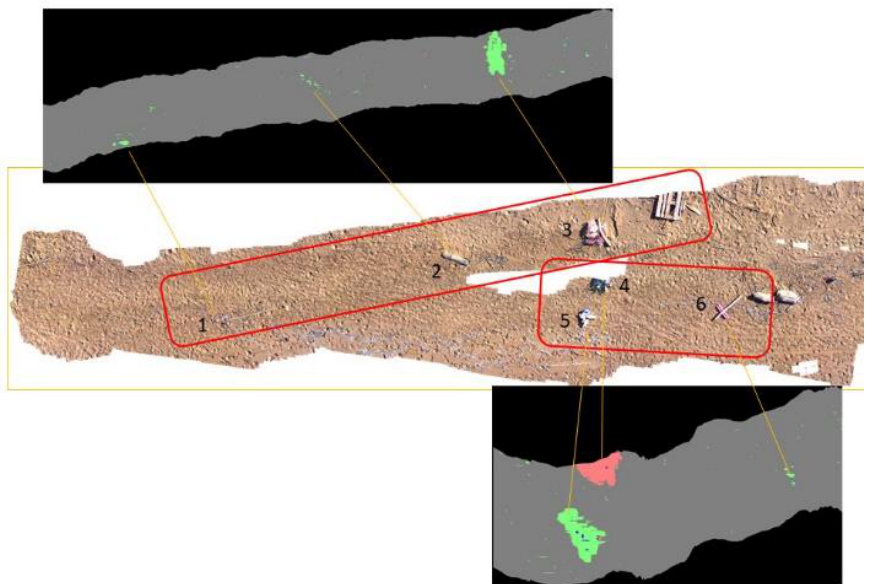
Figure 15. Detection of plastic objects on Porto Ferro beach: (1) Small piece of a plastic football; (2) unidentified debris; (3) PE wrappers; (4) PET bottles; (5) HDPE bottles; (6) Styrofoam floater. The mosaic representing the scene under investigation was obtained from visible spectrum images taken during several passes over the area, the red boxes indicate approximate areas covered by the hyperspectral cubes